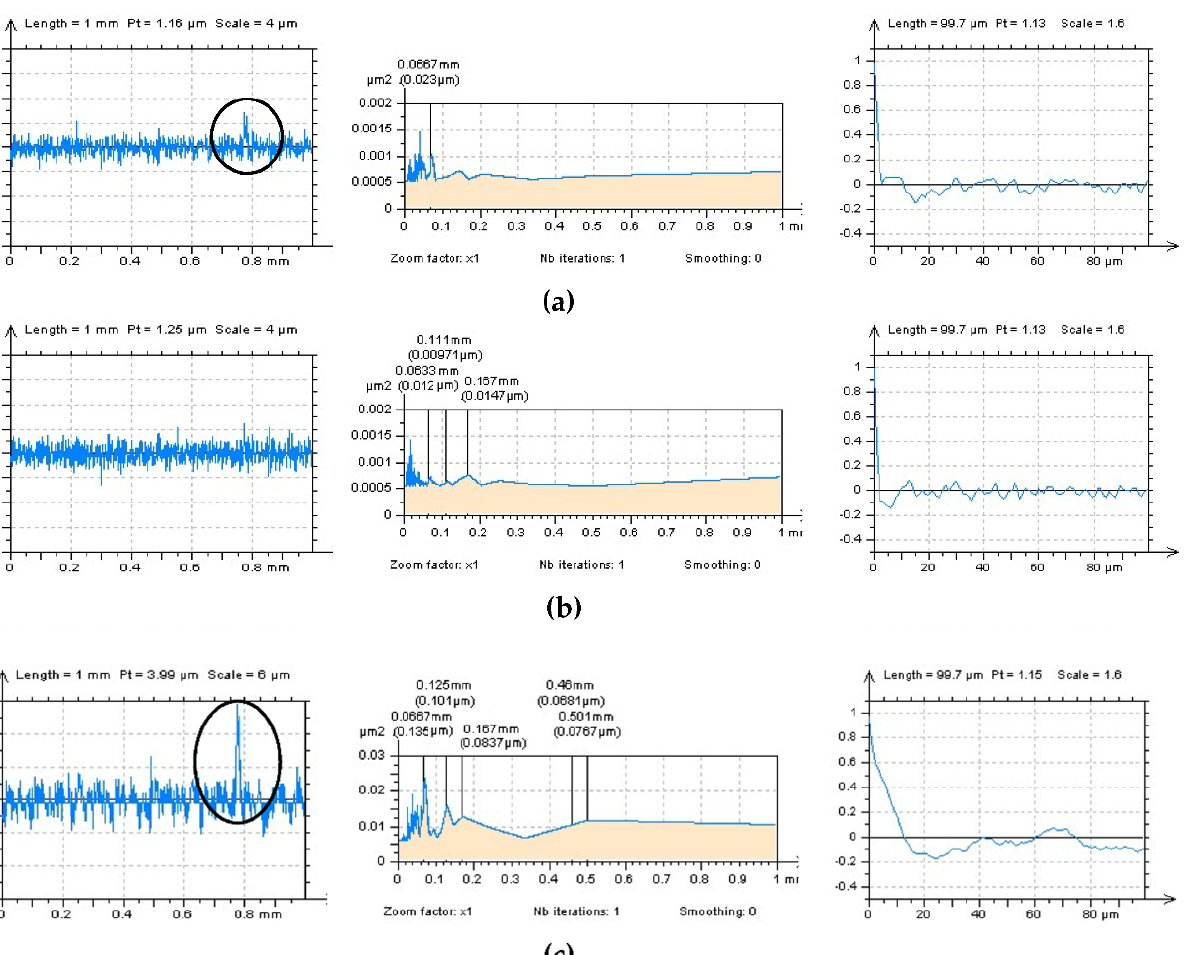
Figure 13. NPs (left column), their PSDs (middle) and ACFs (right), described for profiles from zero wear ( a , b ), running- in ( c , d ) and worn ( e , f ) cylinder liner surface topography measured with 0.5 mm/s velocity and received by GF ( a ), FFTF ( b ), DMF ( c ), SF ( d , e ) and RGF ( f ) approach, with cut-off equal to 0.015 mm ( a , b ), 0.035 mm ( c , d ) and 0.025 mm ( e , f ).